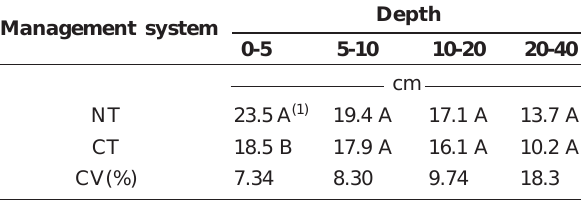
(1) Means followed by the same letter in each column for each layer did not differ by the Tukey test at 1